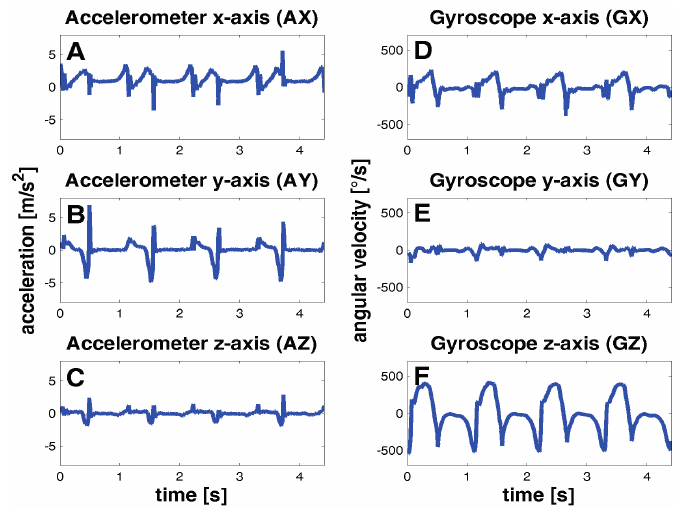
Figure 2. Typical sensor signals of four strides from a straight walk of an elderly control. Left column shows accelerometer signals from movements in ( A ) anterior-posterio; ( B ) inferior-superior and ( C ) lateral-medial direction. Right column shows gyroscope angular velocities of the rotations in ( D ) coronal, ( E ) transverse and ( F ) sagittal